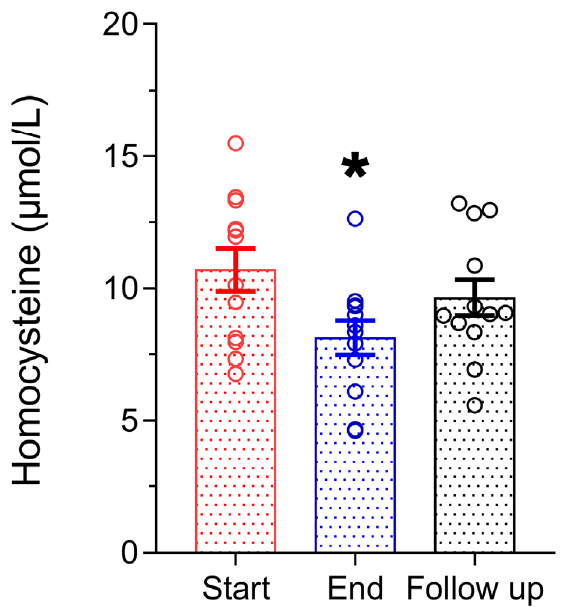
Figure 5. Homocysteine concentration in plasma was significantly decreased after Antiox-Plus treatment ( p < 0.05). This effect was partially reset at follow-up, where homocysteine levels increased but remained lower than in the pro-supplementation period. Statistically significant difference from Start (Day 0) is shown as * ( p < 0.05).